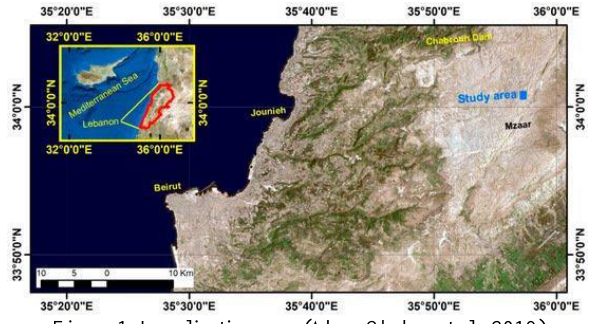
Figure 1: Localization map (Abou Chakra et al., 2019)